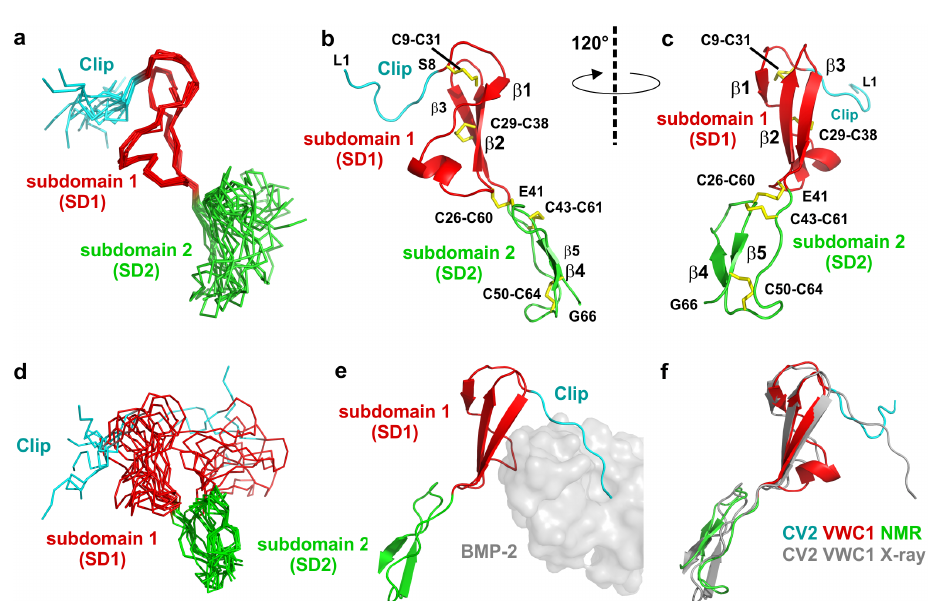
Figure 2. ( a ) Structure ensemble of ten NMR structures of CV2 VWC1 aligned to subdomain 1. ( b ) Ribbon plot of the NMR structure of CV2 VWC1, subdomain boundaries for the Clip segment (L1 to S8) and the subdomains 1 and 2 are indicated, disulfide bonds are shown as sticks. ( c ) As in ( b ) but rotated around the y-axis by 120°. ( d ) Structure ensemble as in ( a ) but aligned on the backbone atoms of subdomain 2. ( e ) CV2 VWC1 bound to BMP-2 (PDB entry 3BK3), the VWC1 domain is shown as ribbon plot, BMP-2 is shown as semi-transparent van der Waals surface in grey. The Clip segment folds into the BMP type I receptor-binding site, subdomain 1 is attached to the BMP type II receptor site. ( f ) Structure alignment of CV2 VWC1 in its bound (indicated in grey) and unbound conformation (labeled CV2 VWC1